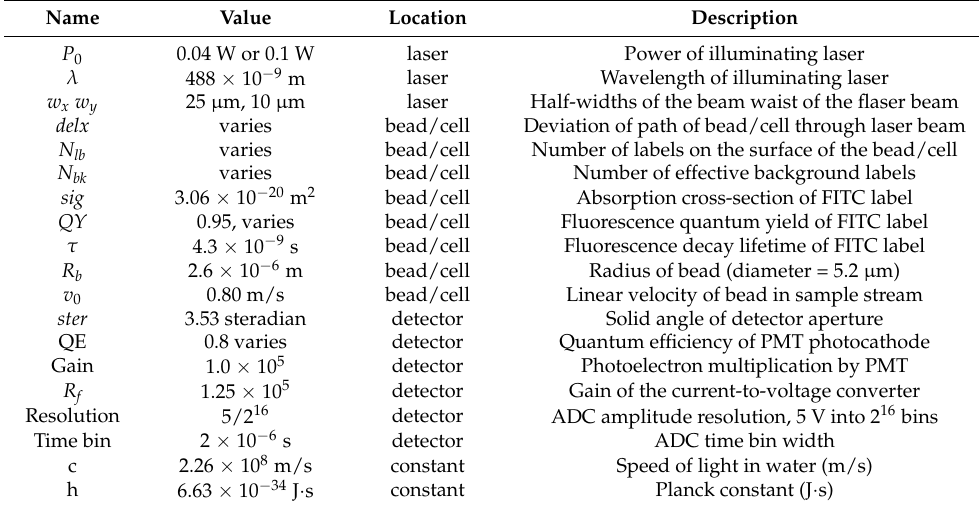
Table 3. Parameters used in the stochastic model of flow